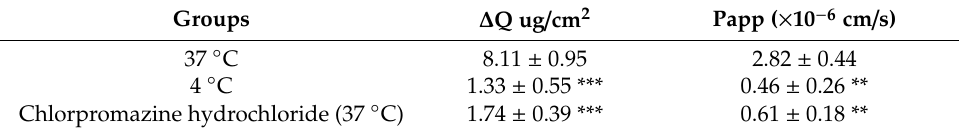
Table 2. E ff ect of temperature and clathrin inhibitor on the absorption of LBP-F.